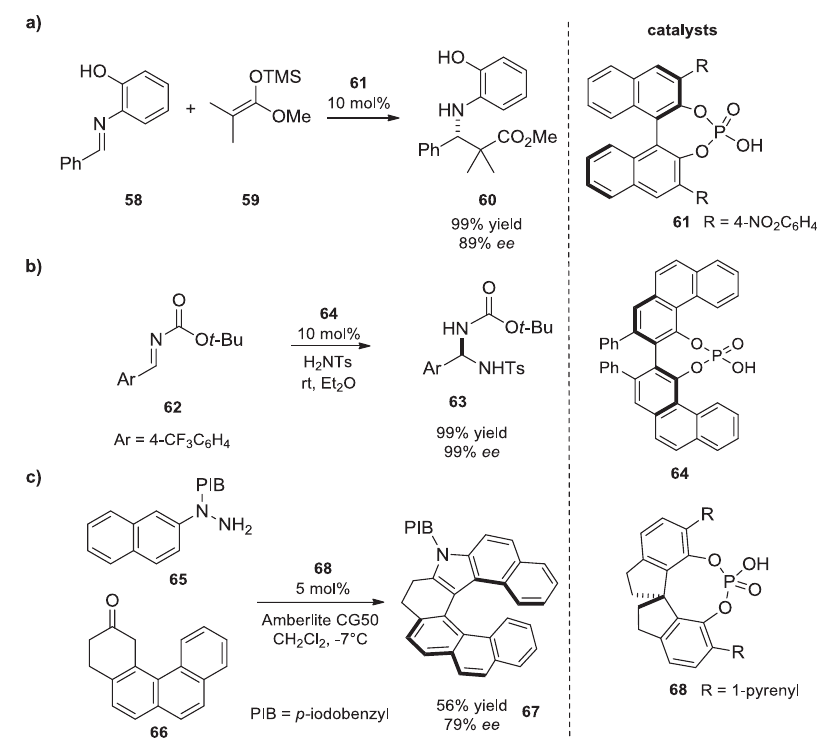
Figure 16. (a) Enantioselective Mannich-Type reaction, from Ref. [77, 78]; (b) Brønsted acid catalyzed imine amidation, from Ref. [87]; (c) Fischer indolization, from Ref. [89].